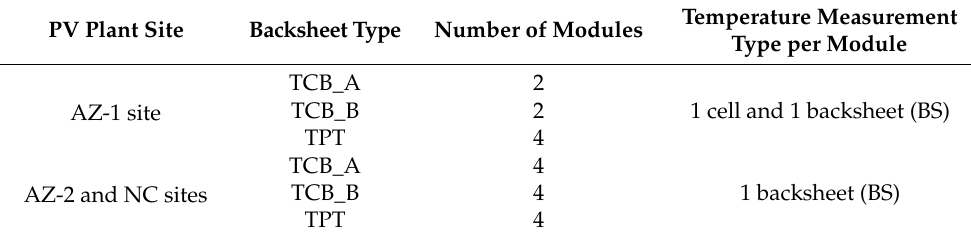
Table 2. Overview of modules at each site.